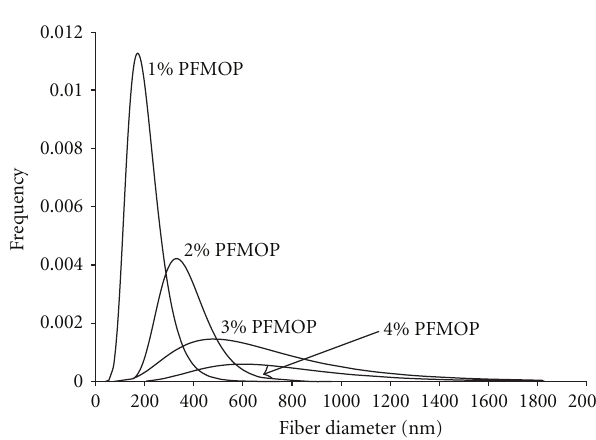
Figure 6: Nanofiber diameter frequency